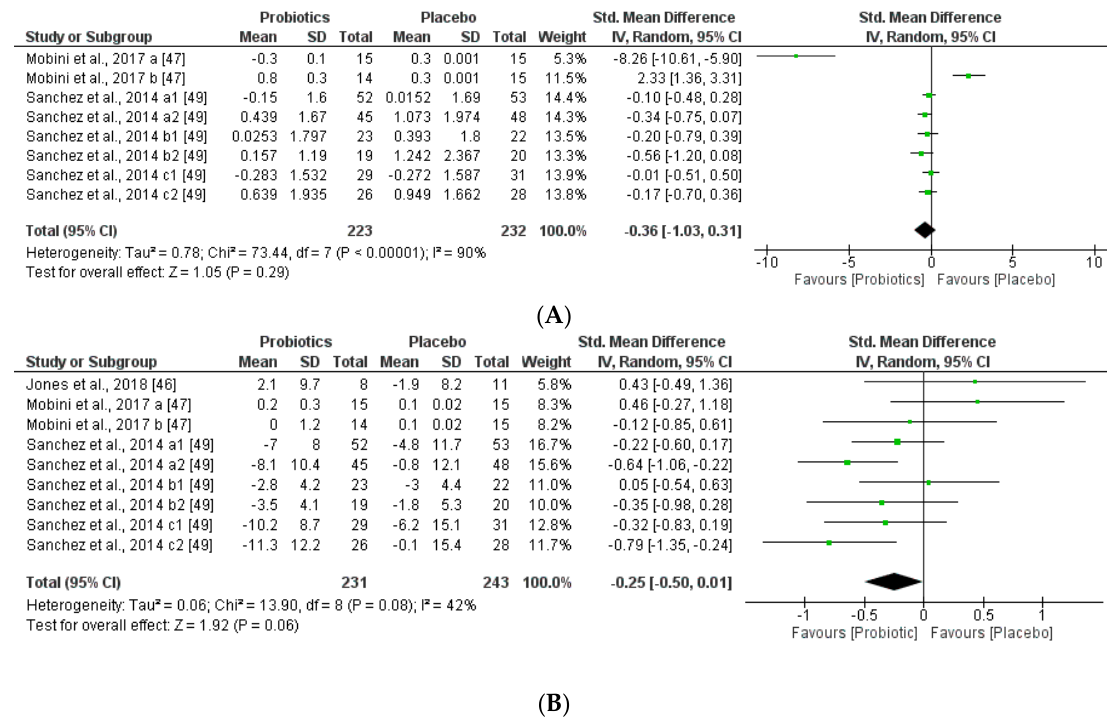
Figure 11. ( A ) Effect of probiotics on adiponectin in CT. ( B ) Effect of probiotics on leptin in CT.